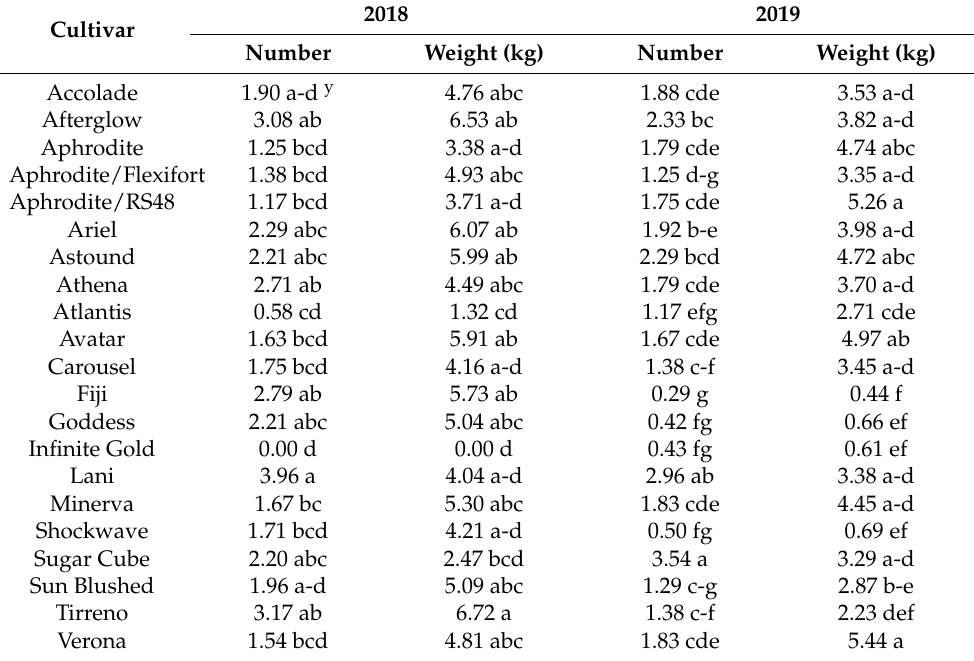
Table 5. Mean marketable number z and weight per plant of 20 muskmelon cultivars and two grafted entries evaluated in central Pennsylvania in 2018 and 2019.